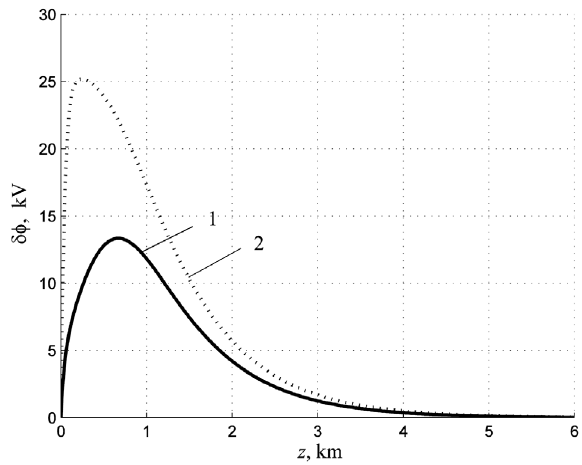
Figure 4. Model calculation of the atmospheric potential difference which might arise in horizontal direction. The potentials were cal- culated at the same altitudes but for different ion production rates, c , which differ by the factor 2. The lines 1 and 2 correspond to r 0 n =2×10 2 cm -3 and n =1.5×10 3 cm -3 , a 0 a 0